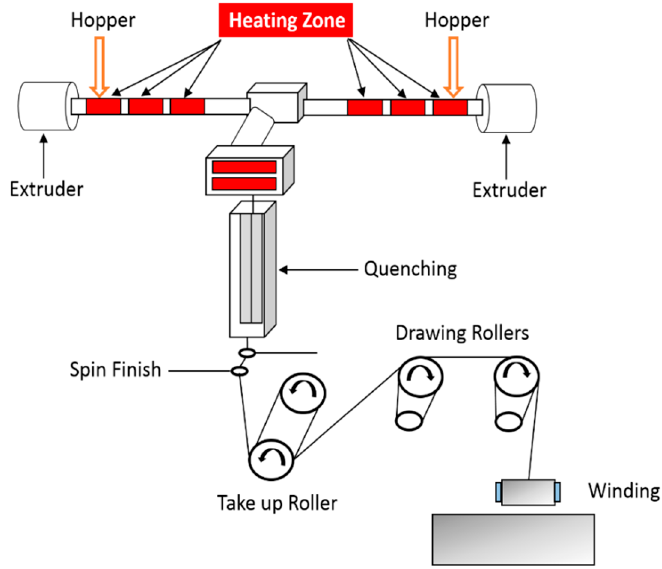
Figure 1. Schematic diagram of pilot scale bicomponent melt spinning machine.